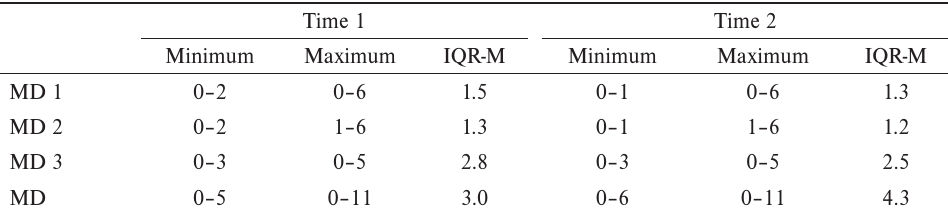
Note. Minimum, maximum = minimum and maximum range; IQR-M = mean interquartile range; MD 1, MD 2, MD 3 = manual dexterity tasks (see Appendix); MD = manual dexterity